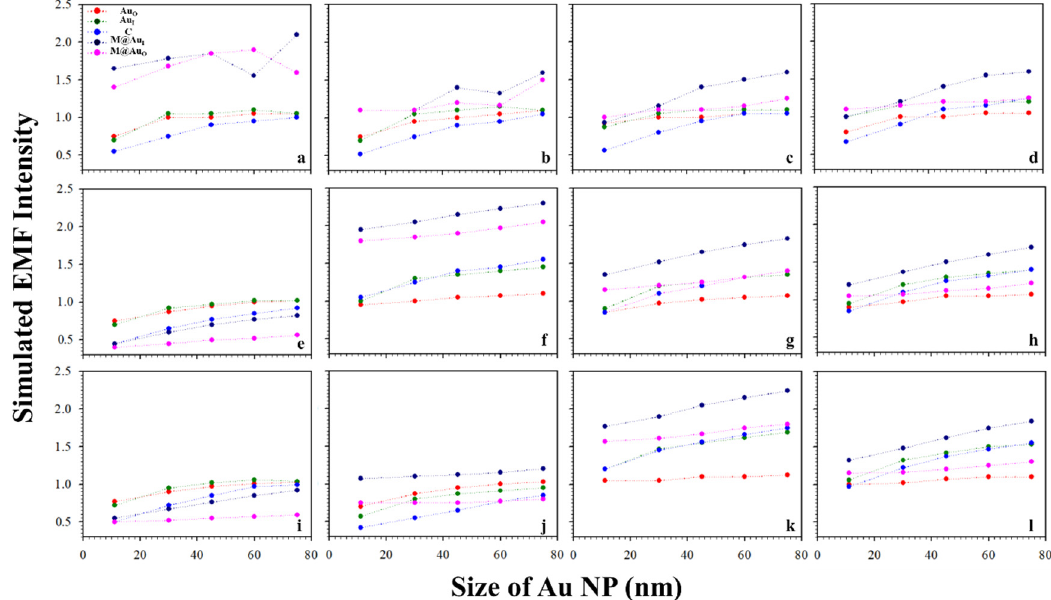
Figure 3. Plots of the simulated EMF intensity for the dimer of “Ab1/Au–CEA–Ab2/M@Au” vs. Au NP size at different locations at the outer-edge of the Au nanoparticles (Au O , red circle), inner-edge of Au nanoparticle (Au I , green circle), the center in-between (C, blue circle), inner-edge of MNP (Fe 3 O 4 core–Au shell) (M@Au I , dark blue circle), and outer-edge of MNP (M@Au O , pink circle). ( a – d ) 6 nm Fe 3 O 4 core–Au shell thickness of 1 ( a ), 3 ( b ), 5 ( c ), and 10 nm ( d ); ( e – h ) 20 nm Fe 3 O 4 core–Au shell thickness of 1 ( e ), 3 ( f ), 5 ( g ), and 10 nm ( h ); ( i – l ) 30 nm Fe 3 O 4 core–Au shell thickness of 1 ( i ), 3 ( j ), 5 ( k ), and 10 nm ( l ).